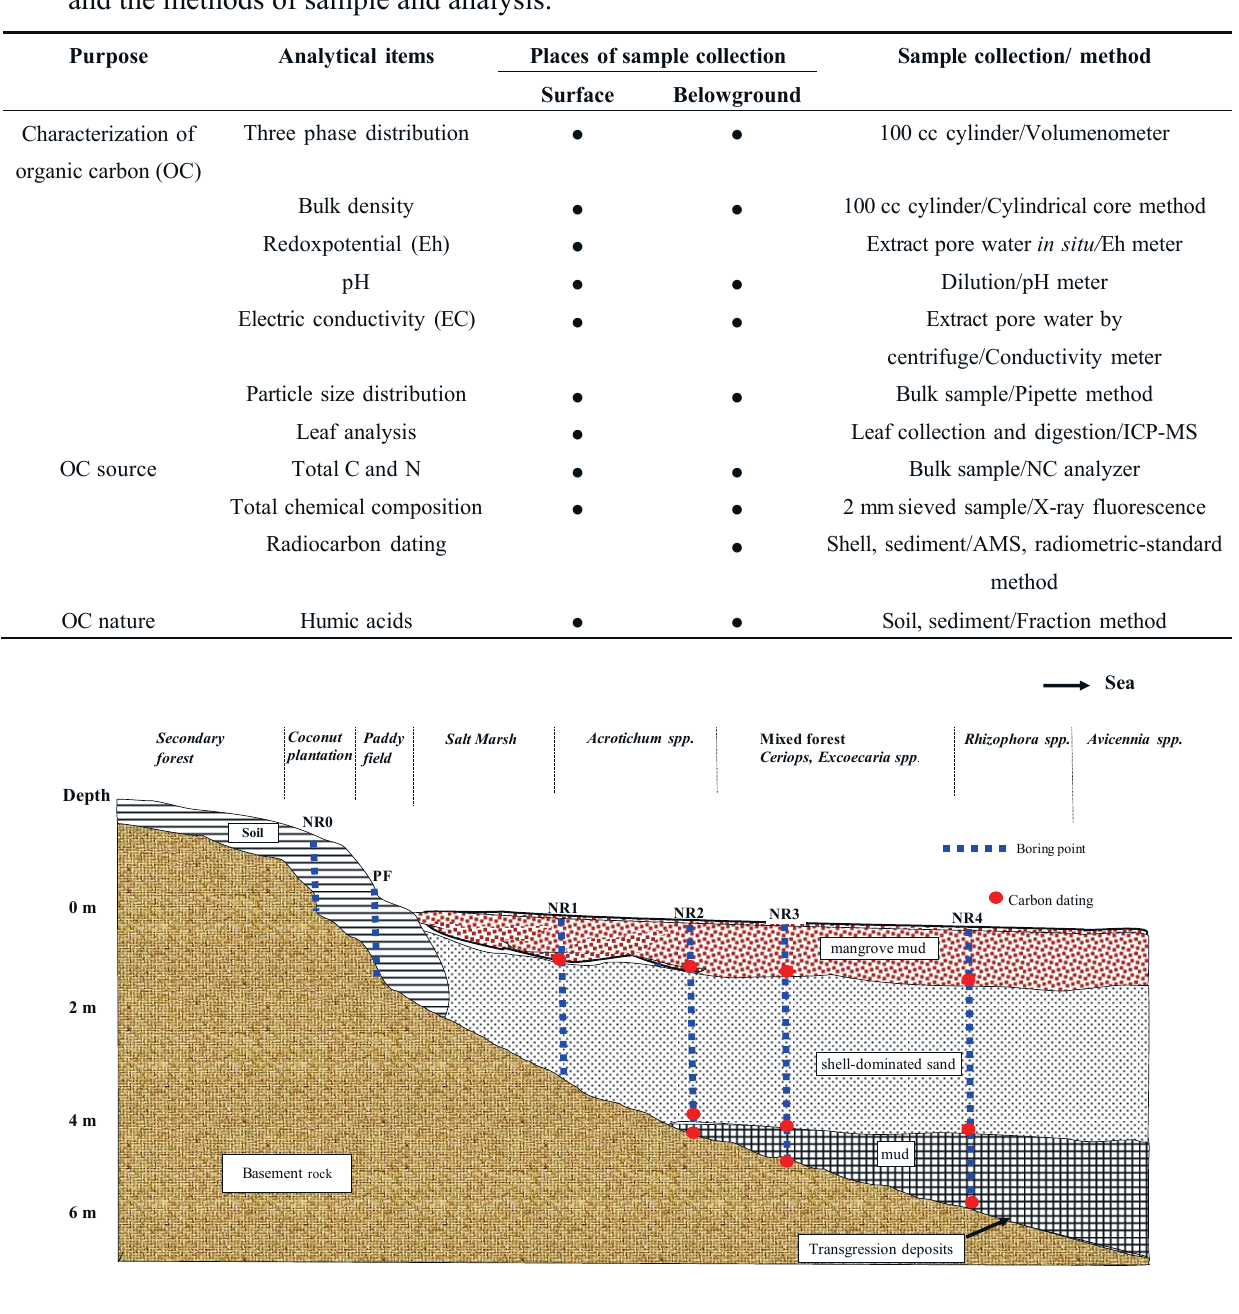
Figure 2. Geologic profile of study site. The mangrove area was composed of three layers: mangrove mud, shell-dominated sand, and mud